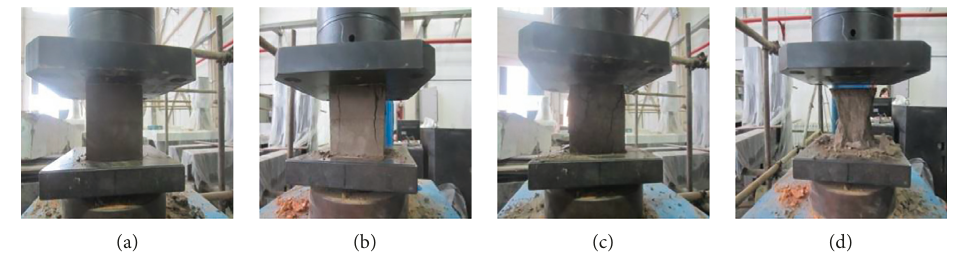
Figure 4: Progress of a black soil cube compressive strength test. (a) Loading. (b) Cracking. (c) Damage. (d) Completely destroyed.